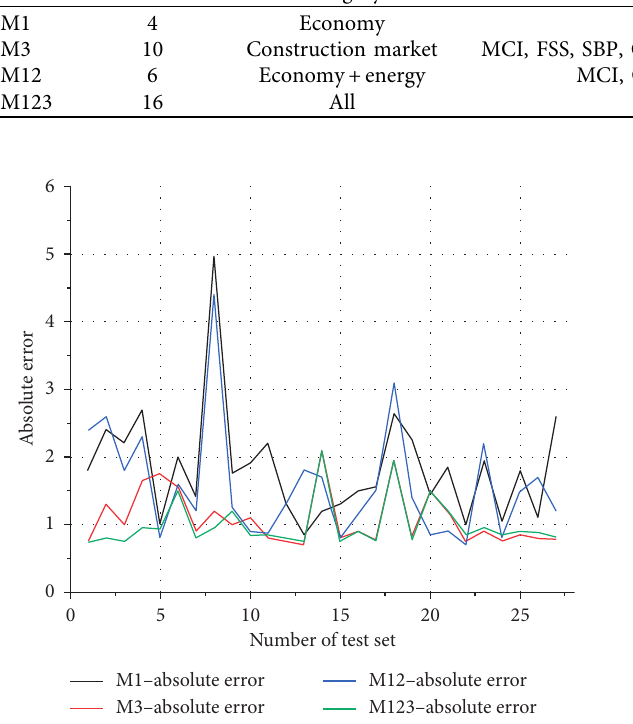
Figure 9: Predictions accuracy and absolute error trends of the models with different time